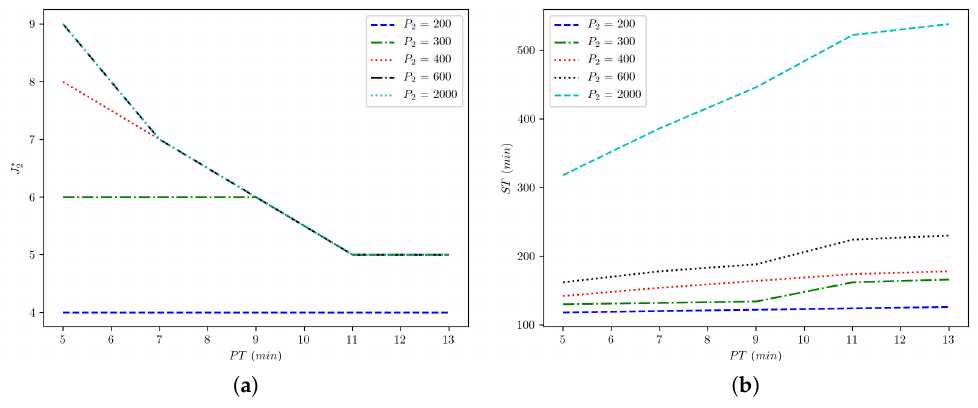
Figure 6. Impacts of change of PT 2 with P 2 on J ∗